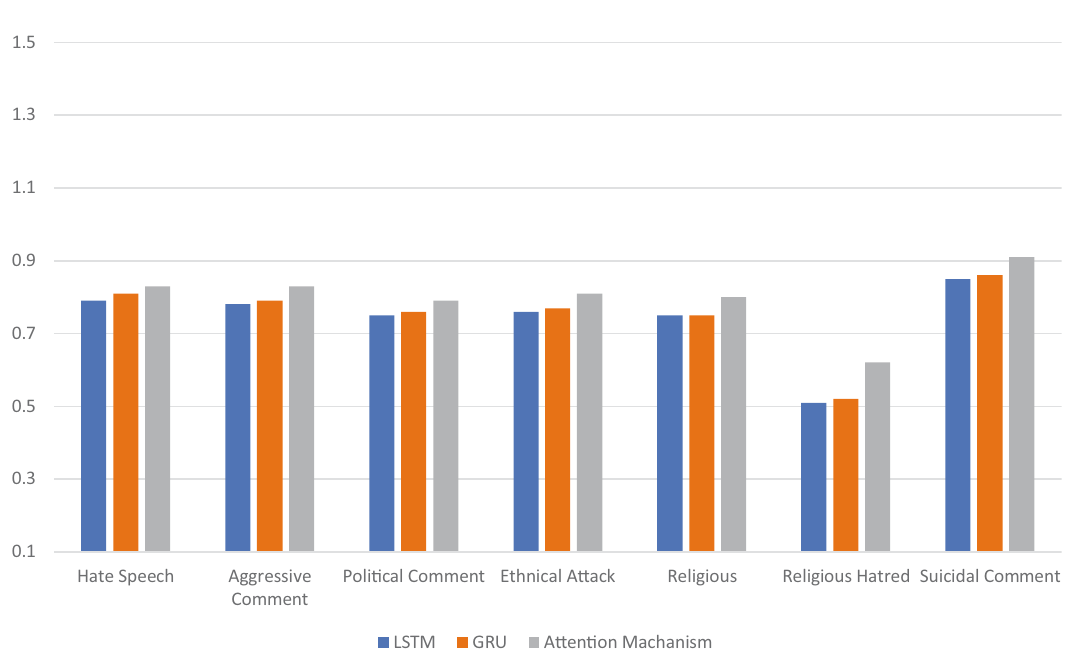
Figure 14: The f1 - score for LSTM ( Long short - term memory ) , GRU ( Gated Recurrent Unit ) , and attention